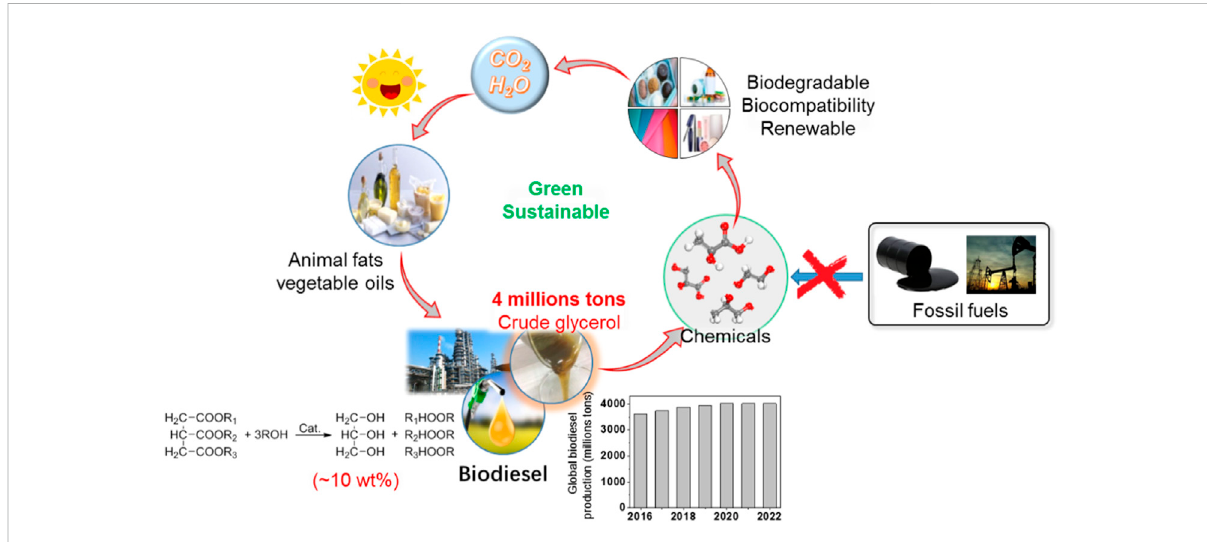
FIGURE 1 Global biodiesel production change in 2016 – 2022 years (millions